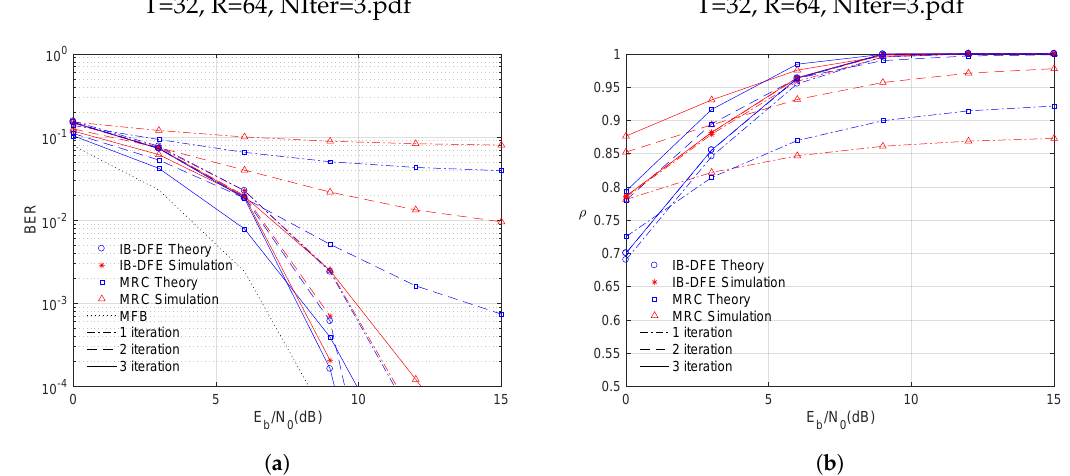
Figure 5. Theoretical/simulated BER performance and correlation factor for IB-DFE and MRC receivers in an mMIMO system with 3 iterations. ( a ) BER performance. ( b ) Correlation factor ( ρ ). T=32, R=64, NIter=3.pdf